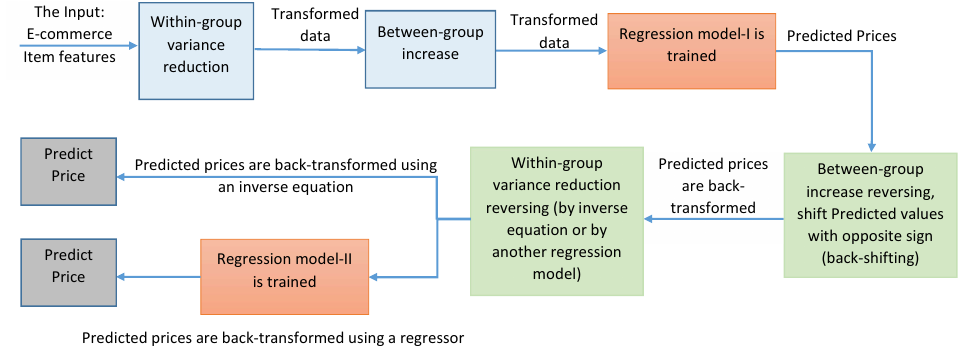
Figure 4. A block diagram of the proposed service with the two proposed data